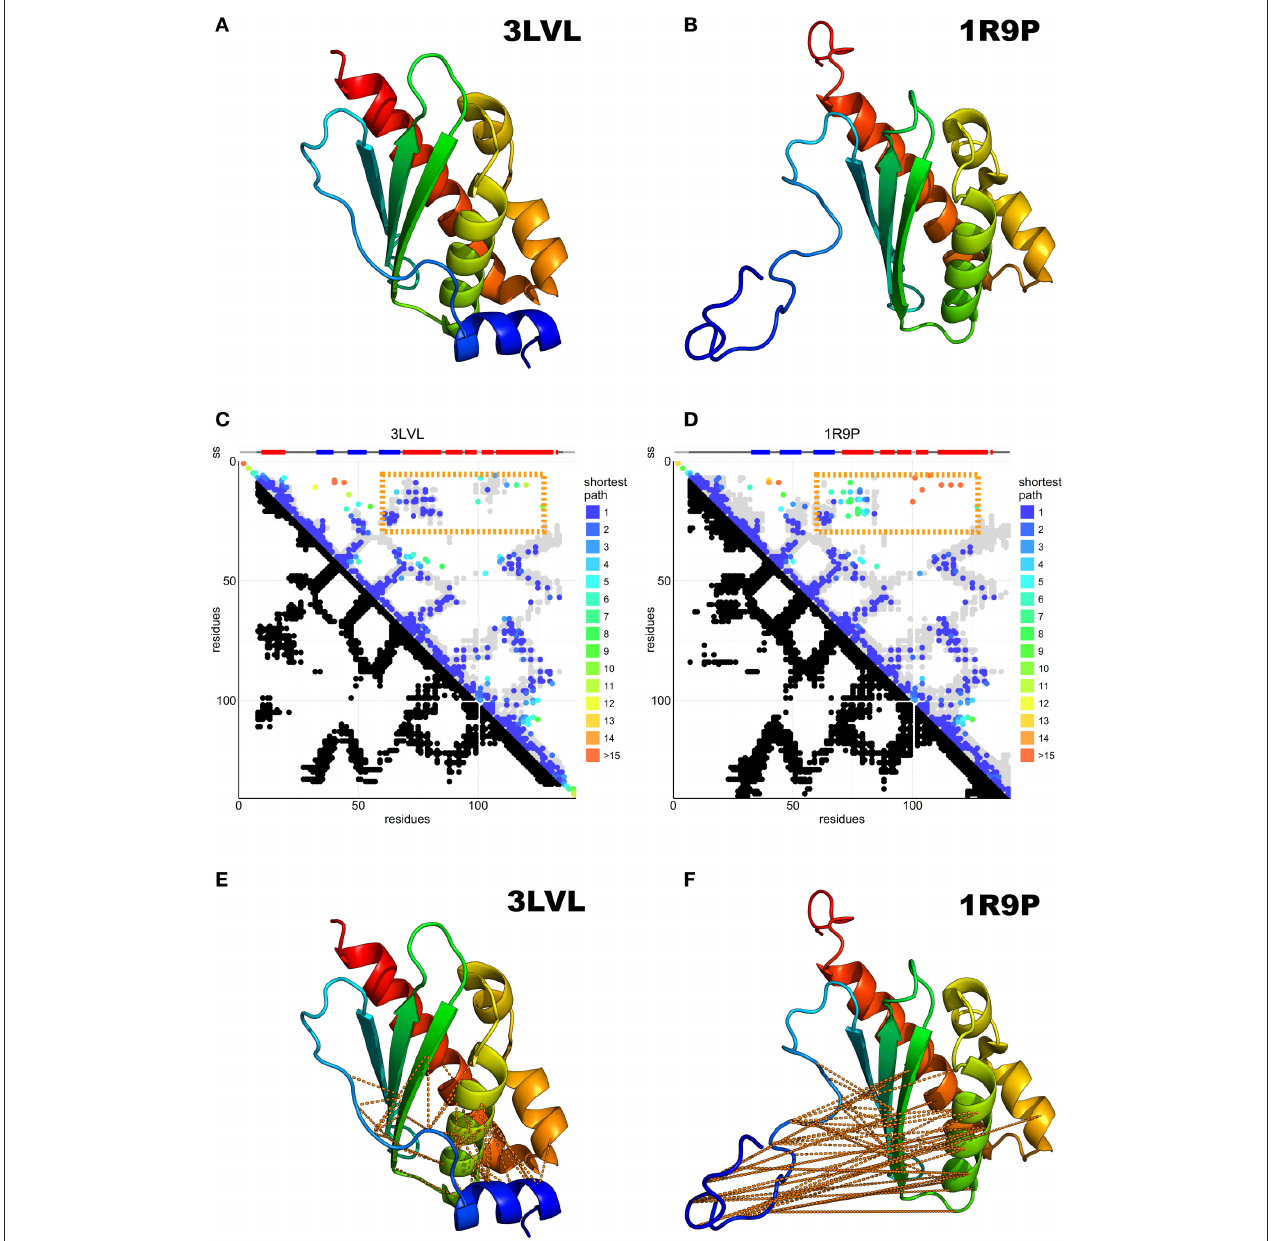
FIGURE 3 | Predicted N-terminal interactions over IscU models with structured (3LVL) or unstructured (1R9P) N-terminus. (A) Crystal structure of IscU (3LVL) illustrating the structured N-terminus. (B) IscU reference structure 1R9P, prototypical of the NMR structures with an unstructured N-terminus. (C,D) DCA on the IscU family over IscU models with structured (3LVL) or unstructured (1R9P) N-terminus. Each axis contains the family consensus sequence from the N- to the C-terminus. Orange frames highlight the contacts missing in the unstructured (A) but present in the structured (B) N-terminus. (E,F). The missing contacts are compared to the structures with an ordered (3LVL) and a disordered (1R9P) N-terminus.